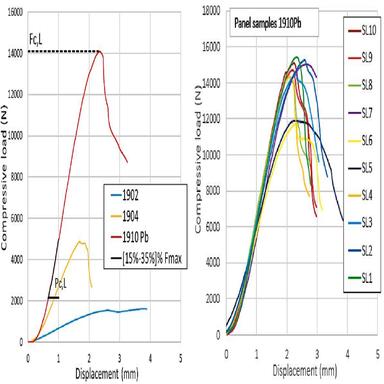
Representative example of the behavior curves of corrugated panels and measurements of their properties, as well as the behavior curves of ten 1910Pb panel samples under longitudinal compressive loading.